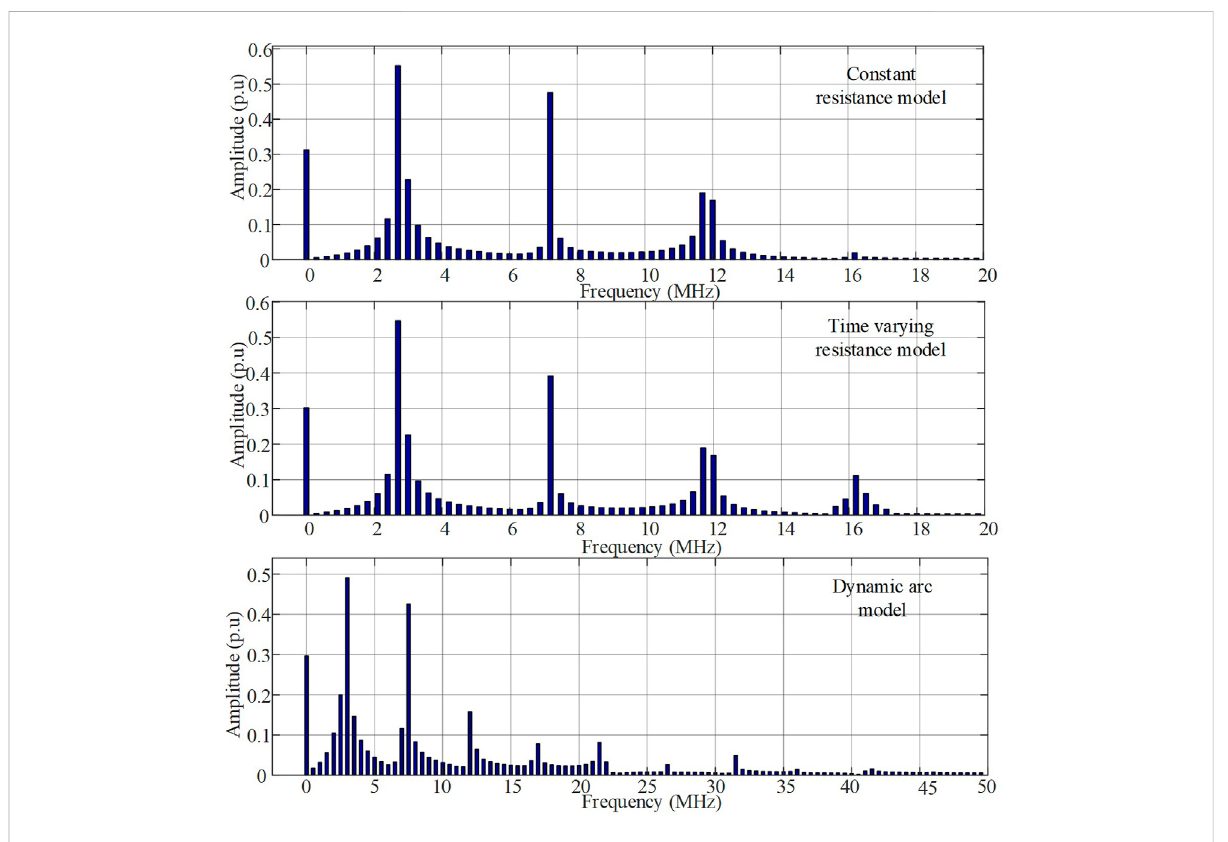
FIGURE 7 Frequency analysis of the fast transient voltage signal under the single arcing